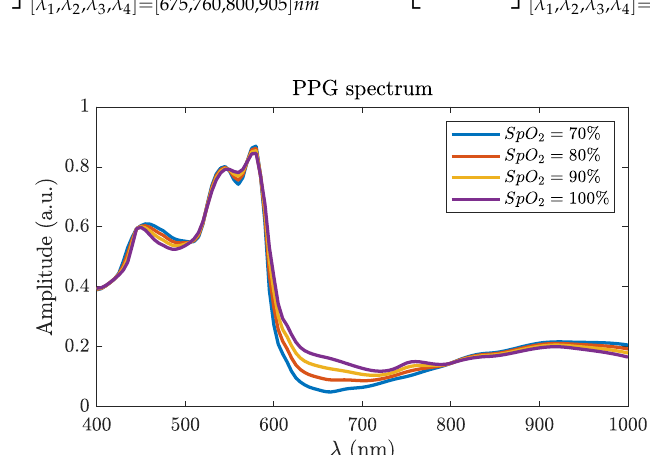
Figure 1. The modeled relative PPG spectrum using the analytic approach by Svaasand et al. [19] for four SpO 2